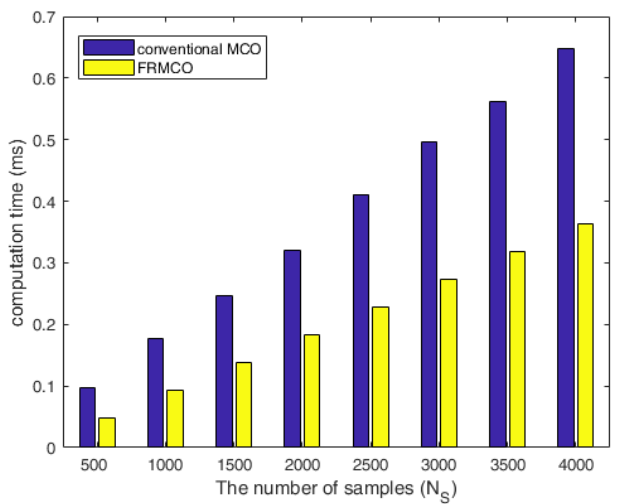
Figure 11. The comparison of computation times between the conventional MCO and the FRMCO according to 𝑁 𝑆 .